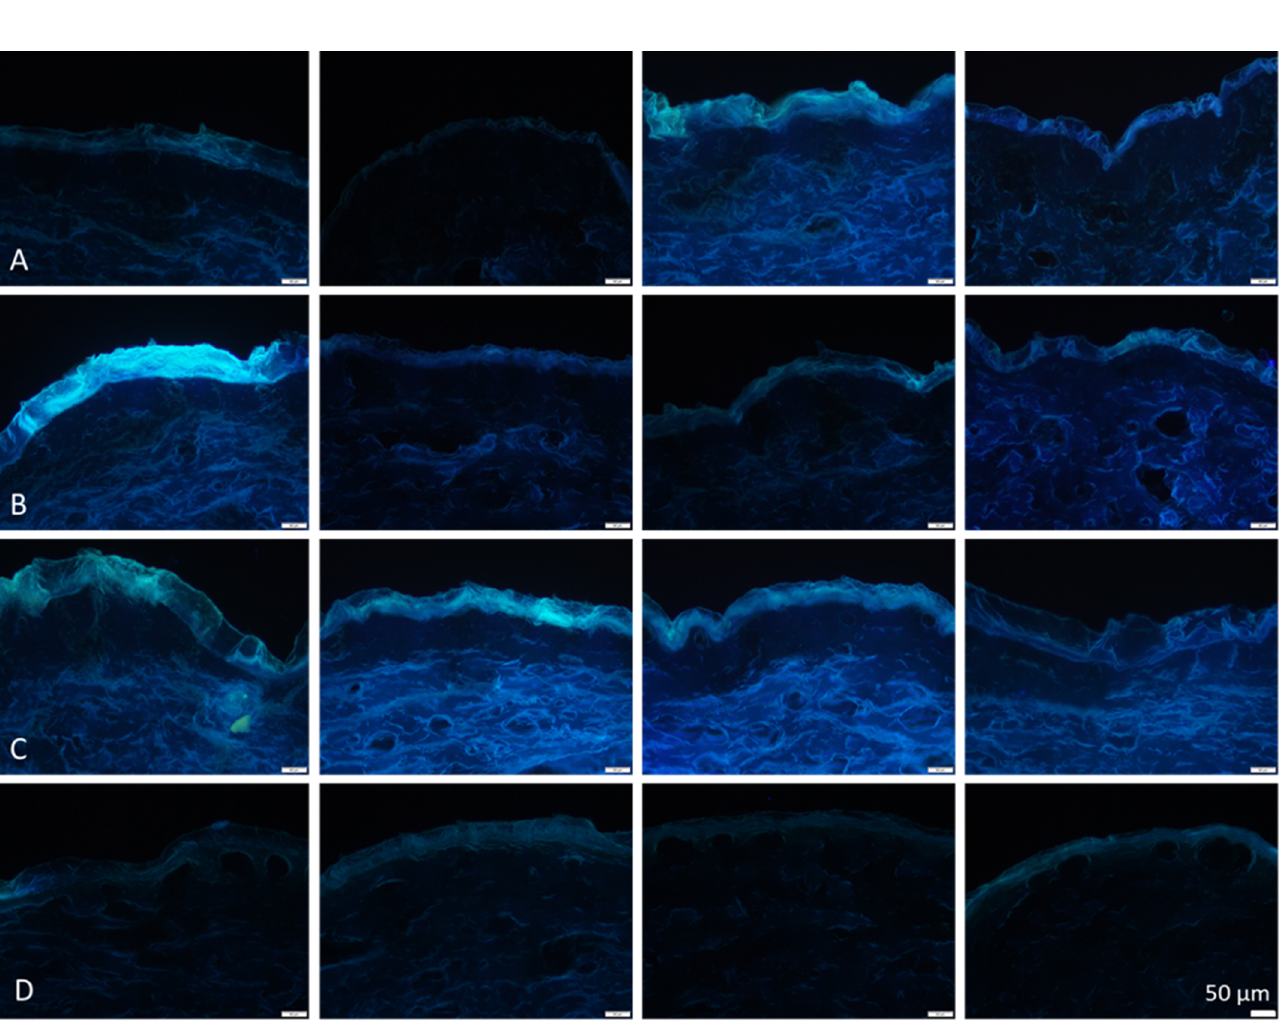
Figure 6. Selected microscopic images from differently aged blank skin biopsies (non-treated skin sections) obtained by inverted fluorescence microscopy (magnification 200-fold, scale bar = 50 µm). ( A ) = fresh ears, ( B ) = ears stored for 24–36 h, ( C ) = ears stored for 48–60 h, ( D ) = frozen and on- demand defrosted ears. Four images were selected for each post-slaughter age to visualize the pronounced variations in skin autofluorescence between the ears.